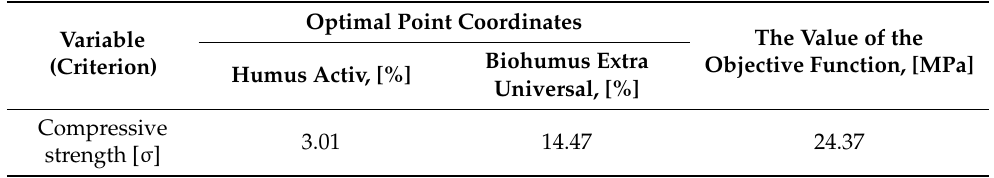
Table 5. Values of the studied factors at optimal points examined variable (compressive strength) and the respective objective